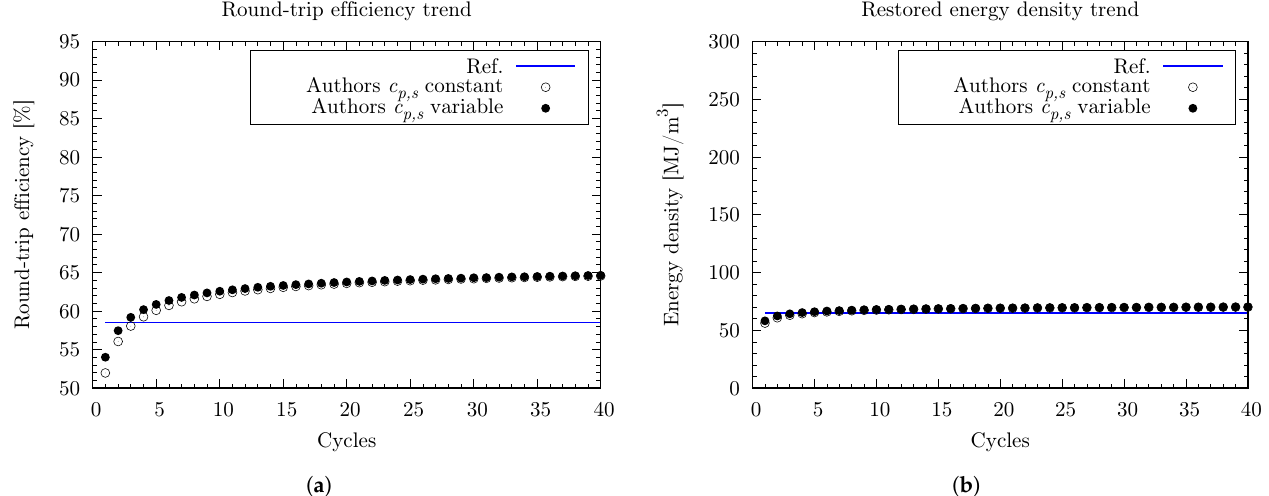
Figure 2. The round-trip efficiency and energy density for the first 40 cycles of the PTES arrangement proposed by McTigue et al. [31]. ( a ) The round-trip efficiency obtained by the authors is compared with the one reported in the reference. ( b ) Energy density, defined as the ratio between the energy re-obtained during the discharging phase and the tanks’ total volume. The latter agrees with that reported in the reference since the energy density is equal to 300 MJ m − 3 in design